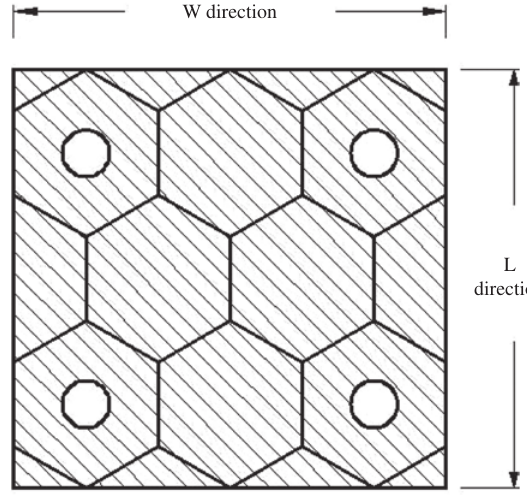
Figure 3: Typical patterns of polymer pins in PFHS